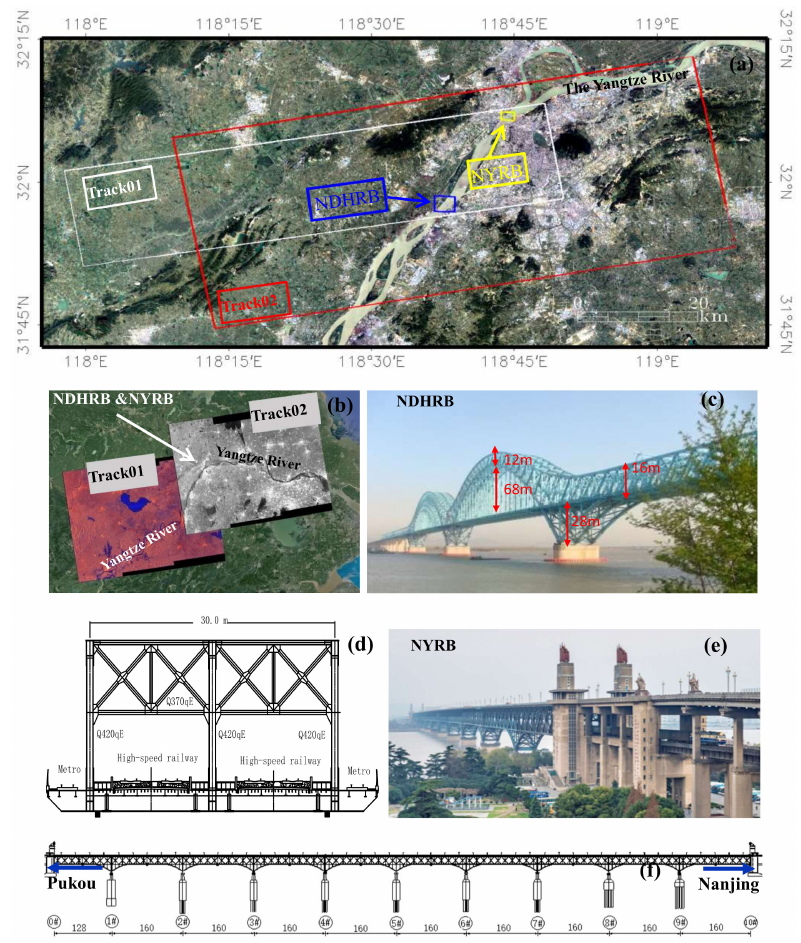
Figure 3. Sentinel SAR image coverage over the two bridges. ( a ) Location of the two bridges and burst coverage (white and red rectangles) of the two ascending SAR datasets used in this study; ( b ) Footprint of the two tracks; ( c ) Photo of the Nanjing-Dashengguan High-speed Railway Bridge (NDHRB), the heights of the structure are taken from Reference [24]; ( d ) Cross-section of the NDHRB; ( e ) Photo of the Nanjing-Yangtze River Bridge (NYRB); ( f ) Layout of the